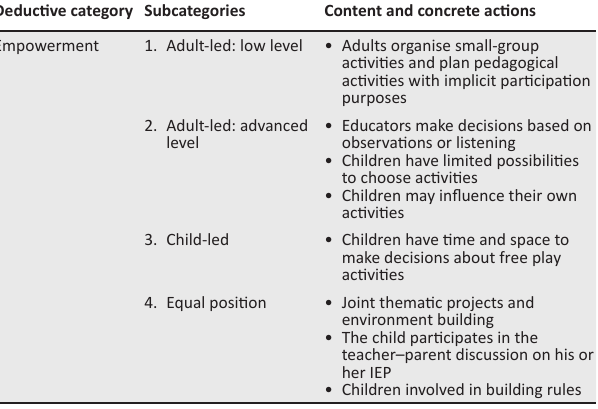
TABLE 4: Empowerment as a participation dimension. Deductive category Subcategories